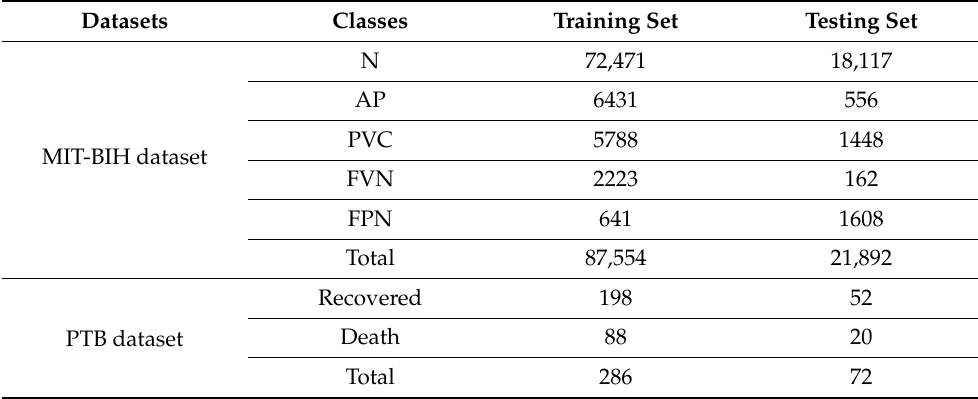
Table 1. The number of subjects for the MIT-BIH and PTB